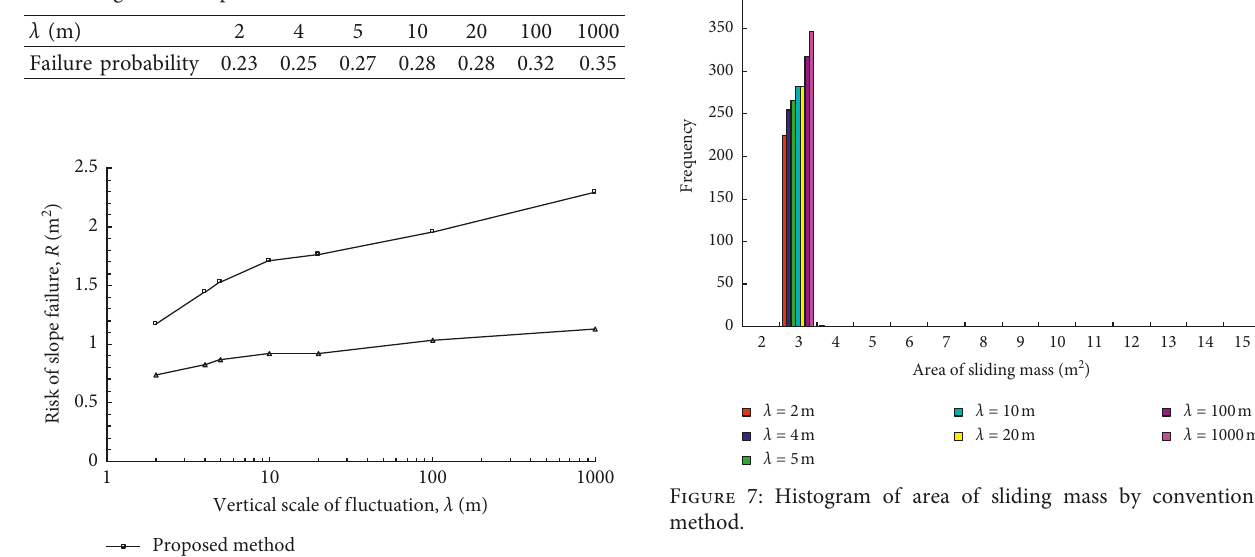
Table 1: Variation of failure probability with different λ values for the homogeneous slope.